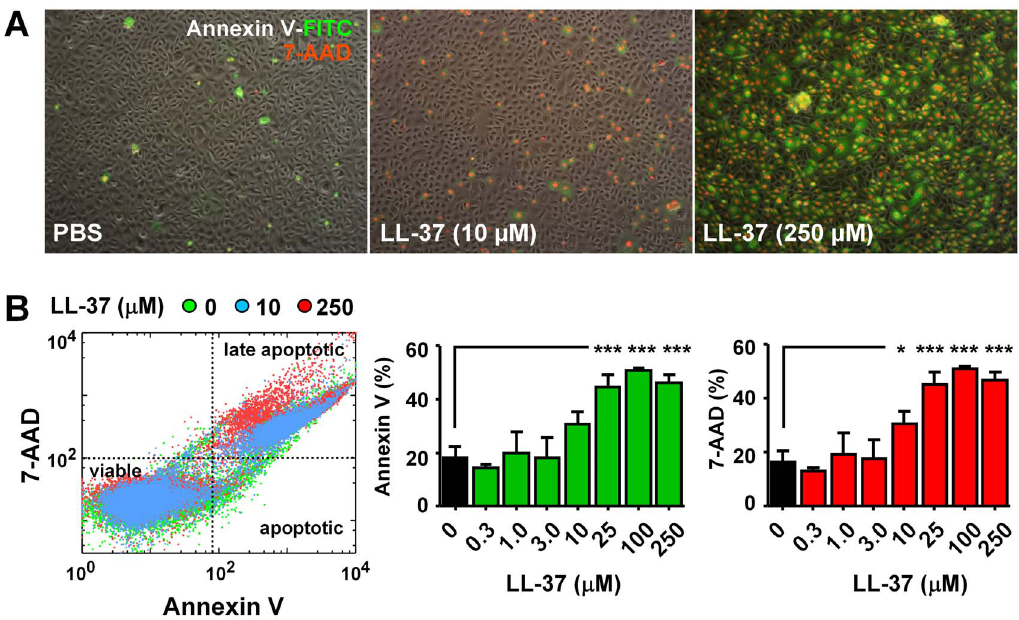
Figure 3. LL-37 induces apoptotic cell death in human urothelial cells (HUCs). Cultured HUCs were treated with LL-37 for 15 min at 37 u C. HUCs were then collected and labeled with annexin V-FITC (shown in green) and 7-AAD (shown in red). A, Fluorescence microscopy shows the increased number of apoptotic cells in LL-37 treated HUCs (magnification 10 x ). B, Flow cytometry analysis of HUCs shows that LL-37 induces apoptotic cell death at $ 10 m M or higher concentrations of LL-37. * p , 0.05 and *** p , 0.001 by Dunnet’s t -test.